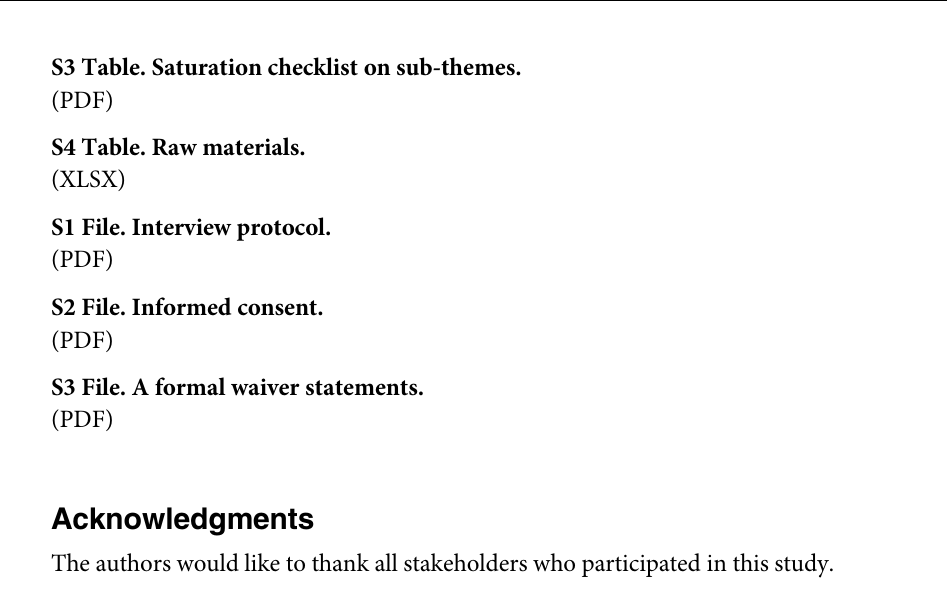
S3 Table. Saturation checklist on sub-themes. S4 Table. Raw